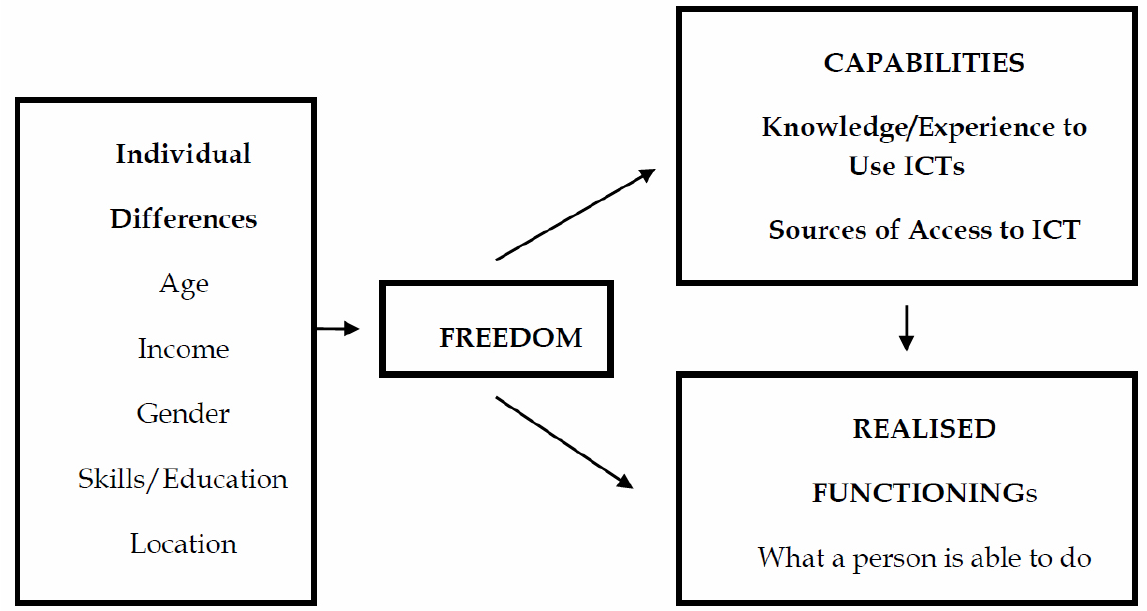
Figure 3: The Capability Approach Applied to Access to ICTs (Source: Alampay, 2006